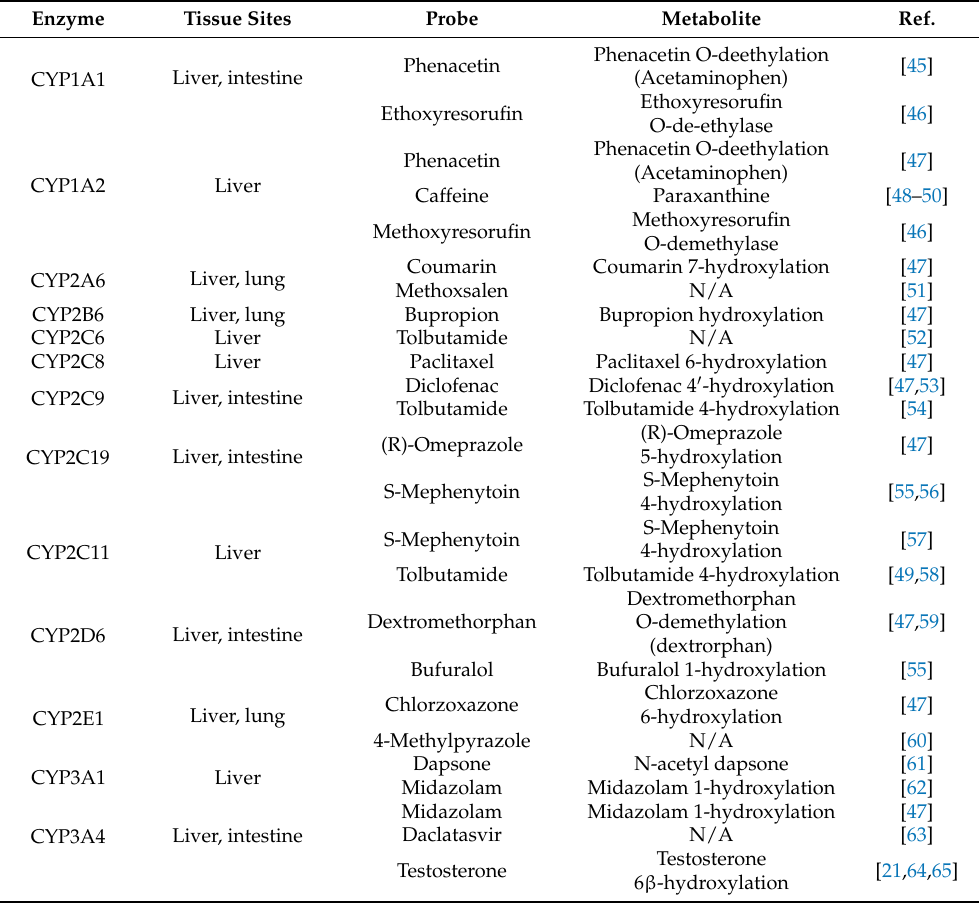
Table 1. Commonly used CYP450s and their substrate in probe assays along with the HPLC-MS methods.